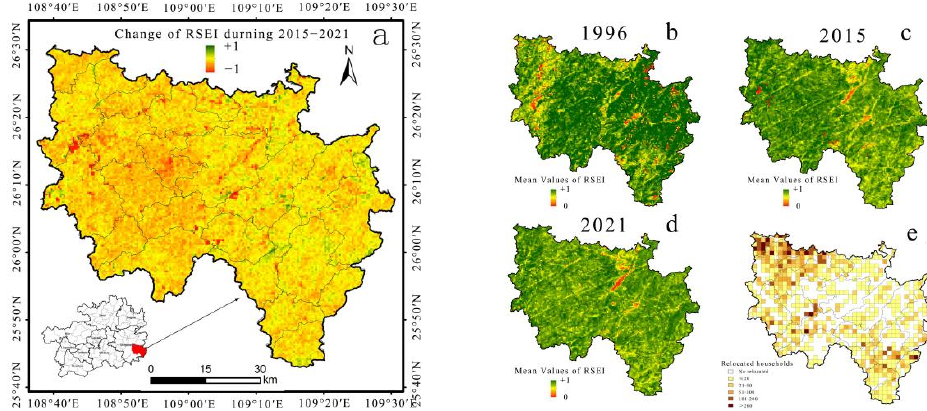
Figure 11. Liping RSEI change. ( a ) Liping RSEI change (2015–2021); ( b ) Liping RSEI in 1996; ( c ) Liping RSEI in 2015; ( d ) Liping RSEI in 2021; ( e ) PAR population distribution in